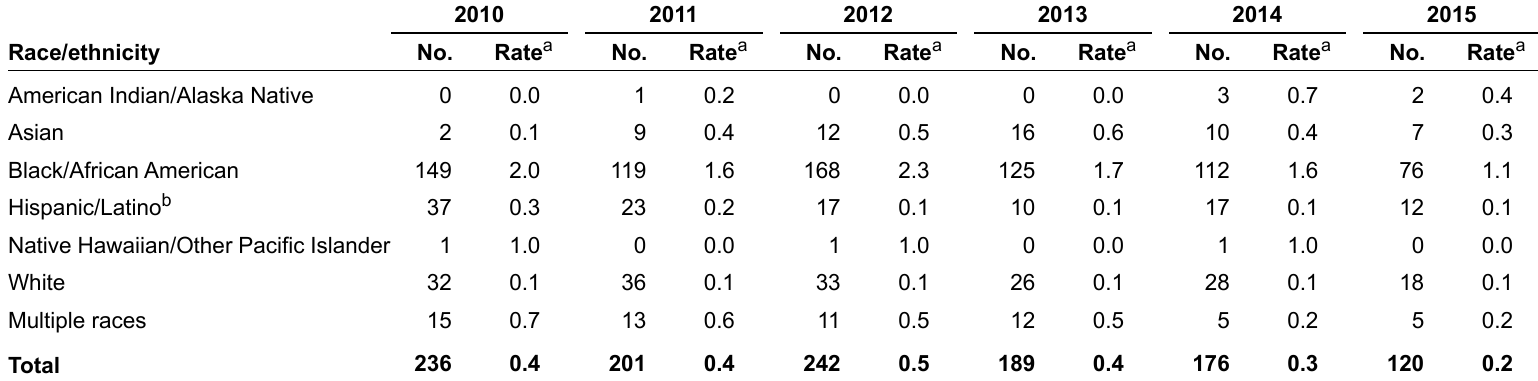
Table 7a. Diagnoses of HIV infection among children aged <13 years, by race/ethnicity, 2010–2015—United States